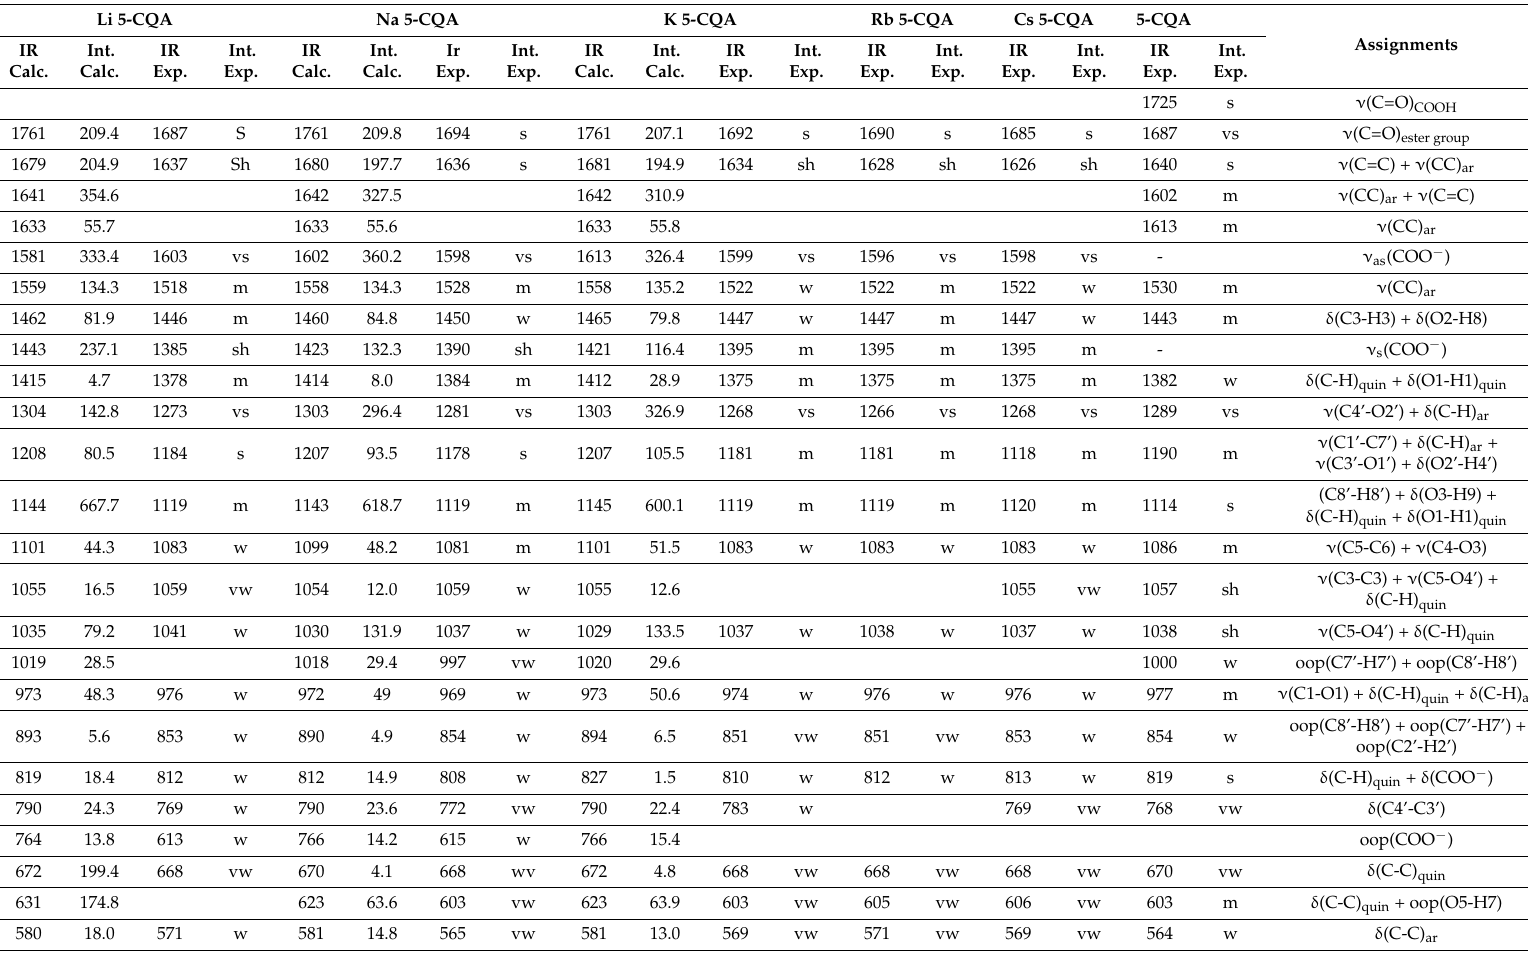
Table 1. The wavenumbers and intensities of the bands from the experimental and theoretical (in B3LYP/6-311++G** level) FT-IR (infrared) spectra of alkali metal chlorogenates and chlorogenic acid [2]; the symbols denote: ν —stretching, δ —deforming in plane and oop—out of plane bending vibrations; s—strong, m—medium, w—weak, v—very, sh—shoulders. Li 5-CQA Na 5-CQA K 5-CQA Rb 5-CQA Cs 5-CQA 5-CQA AssignmentsIR Int. IR Int. IR Int. Int. Calc. Calc. Exp. Exp. Calc. Calc. Exp.